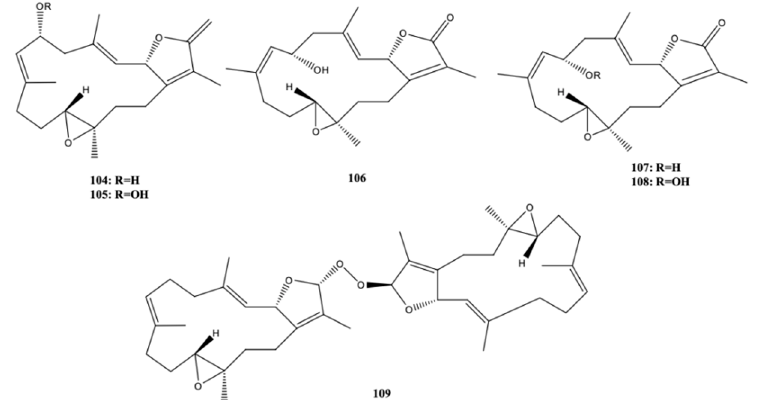
Figure 10. New cembranoid diterpene isolated from S. cherbonnieri from the Jihui Fish Port, Taiwan (Philippine Sea) [35].